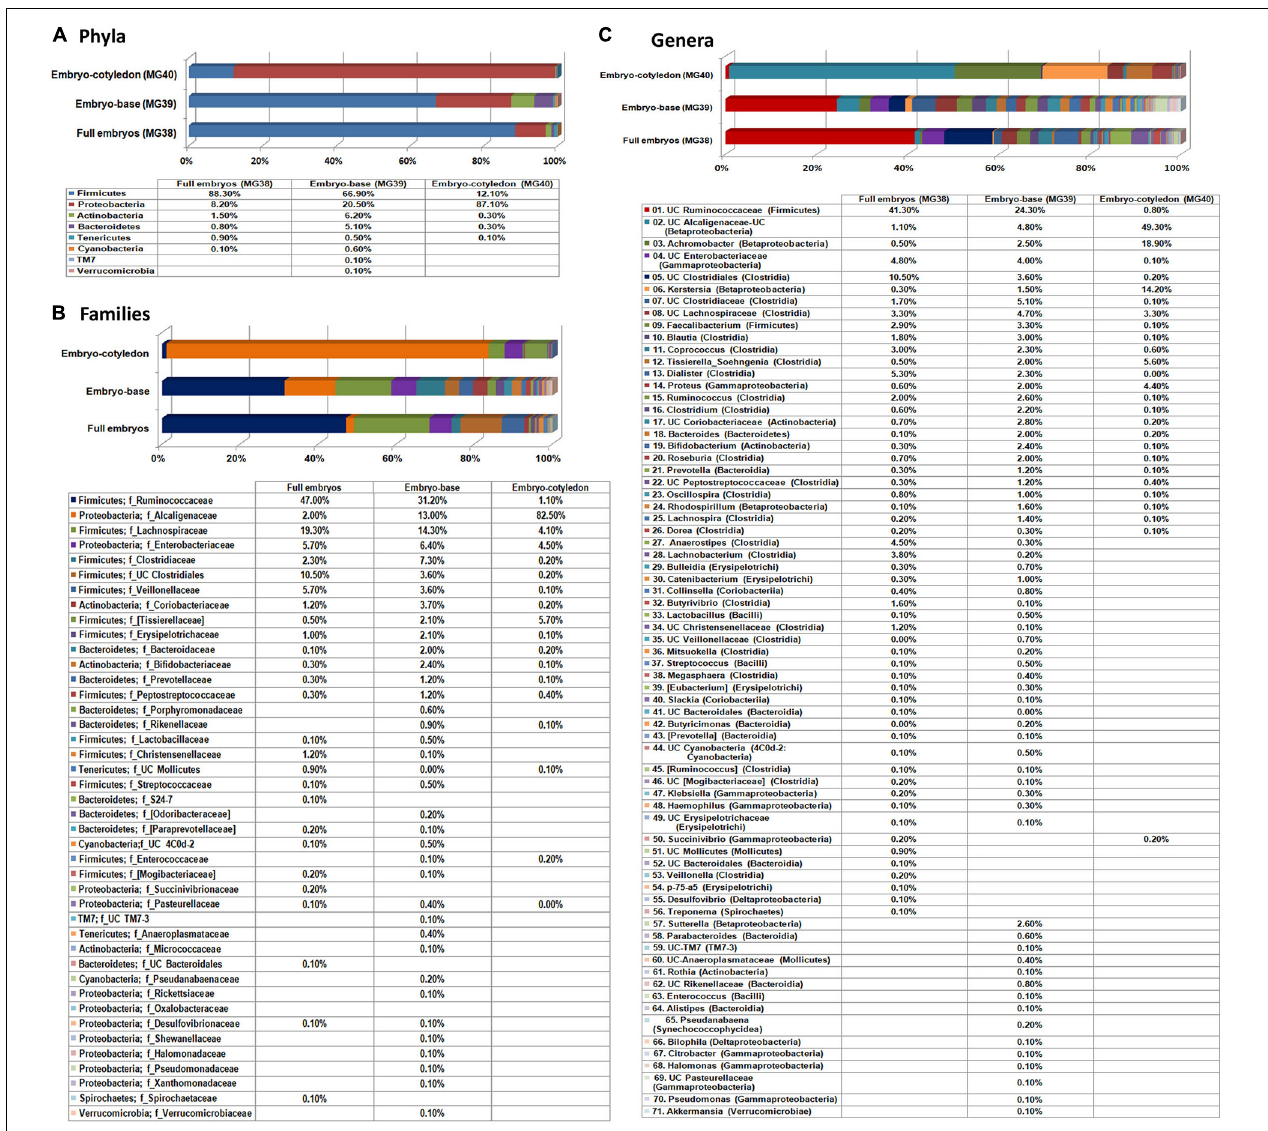
FIGURE 4 | Distribution of phylogenetic groups as per 16S rRNA metagene V3–V4 region taxonomic profiling of DNA derived from the whole excised seed embryos of watermelon “Arka Manik,” seed embryo base and seed embryo cotyledons at phylum (A) , class (B) , and family (C)